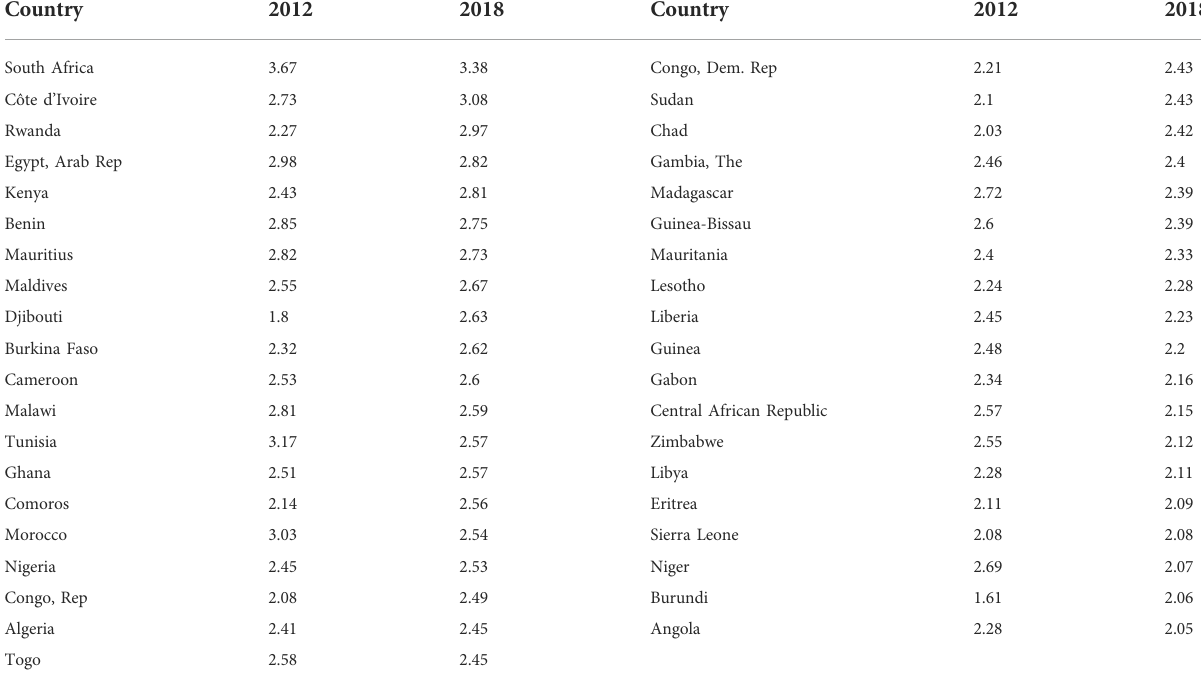
TABLE 2 Overall LPI score of SSA